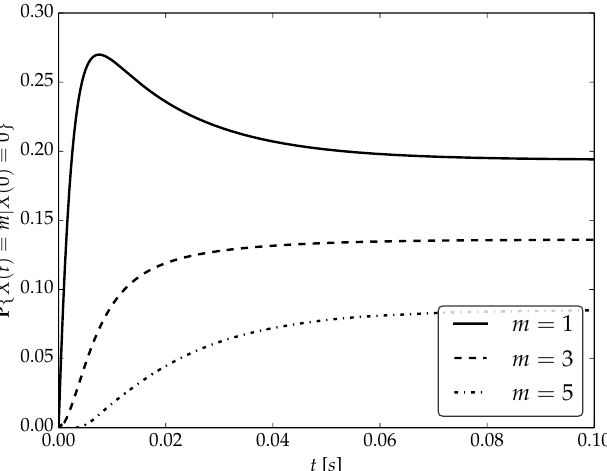
for P 1 , ρ = 0.75 and mean setup time X ( t ) = m X ( 0 ) = 0 { | }